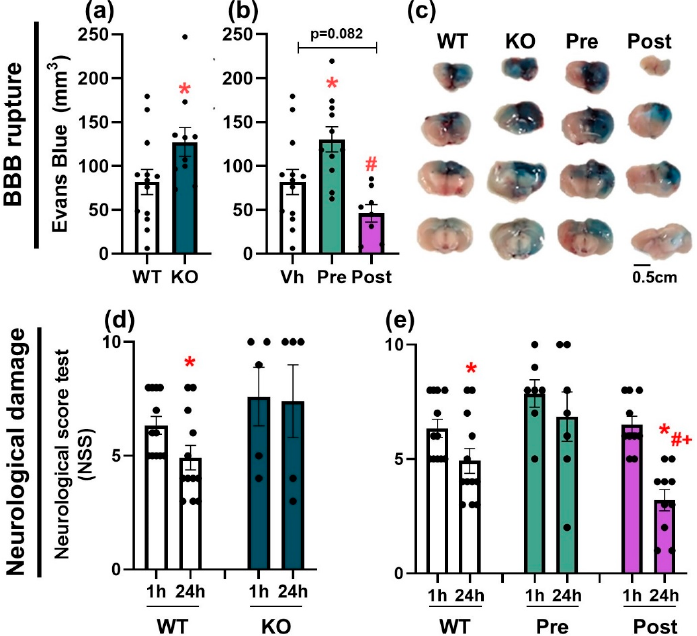
Figure 4. Genetic and pharmacological approach for NLRP3 inactivation. ( a ) BBB rupture in WT and KO mice 24 h after trauma. Mean ± SEM ( n = 10–13). ( b ) BBB rupture in vh-, preMCC950-, and post-MCC950-treated mice. Mean ± SEM ( n = 8–13). Kruskal–Wallis or one-way ANOVA followed by Mann–Whitney or Bonferroni’s tests p ≤ 0.05. (* vs. WT (Vh); # vs. Pre). ( c ) Representative pictures